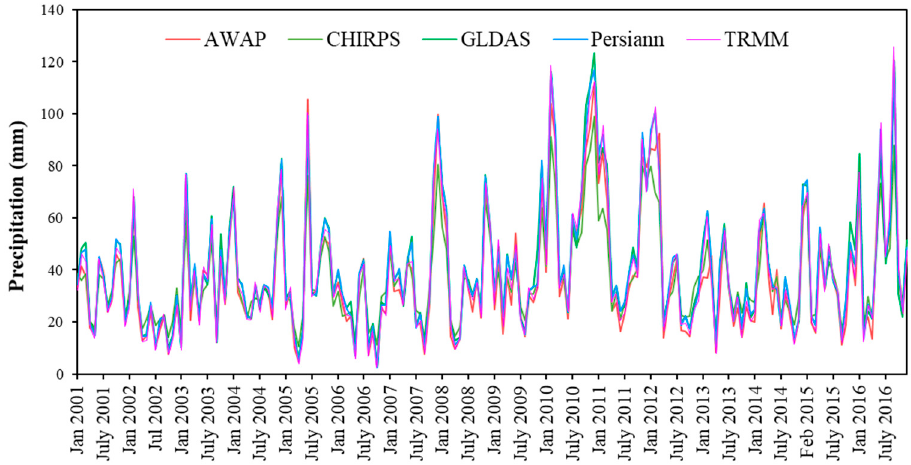
Figure 2. Monthly average precipitation in Murray Darling Basin presented with different products. precipitation products.